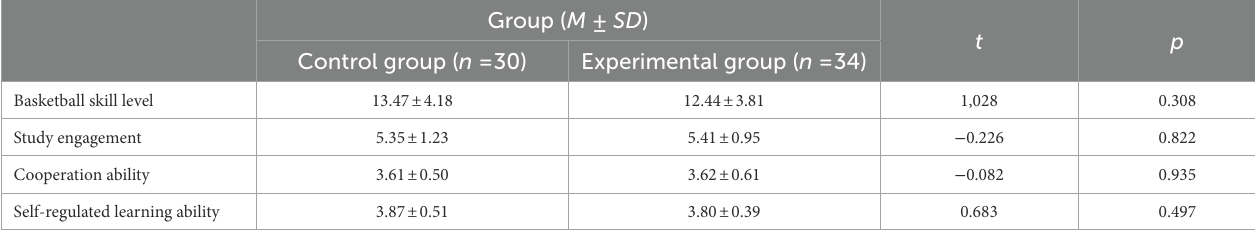
TABLE 1 Analysis of t -test results of independent samples in the experimental group and the control